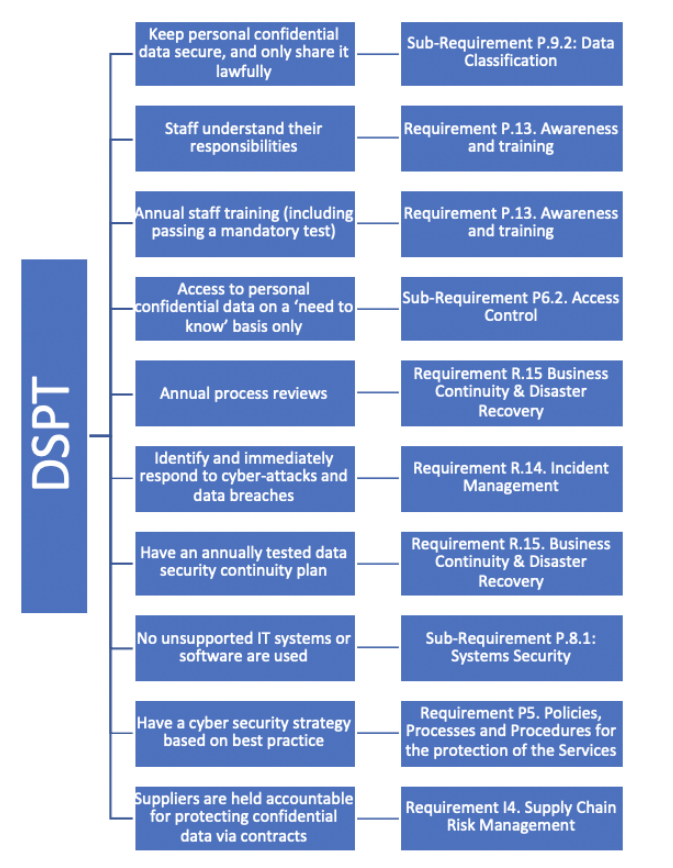
Figure 5. Data Security and Protection Toolkit (DSPT) Mapping.